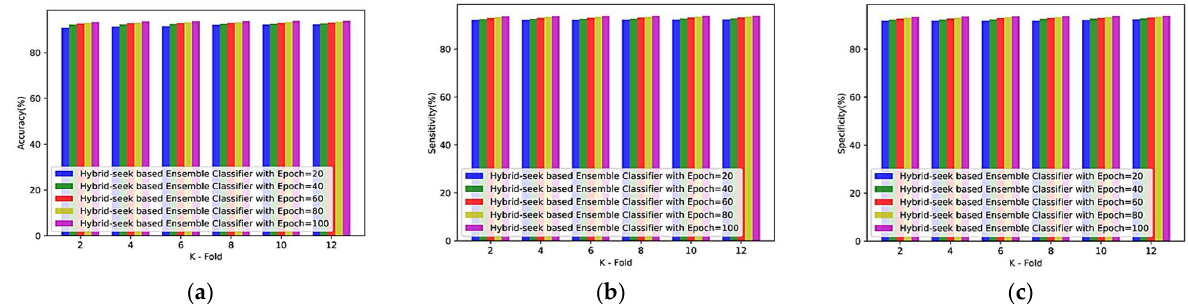
Figure A2. Analysis of performance using the CHB-MIT dataset in terms of k-fold value ( a ) accuracy, ( b ) sensitivity, and ( c ) specificity.